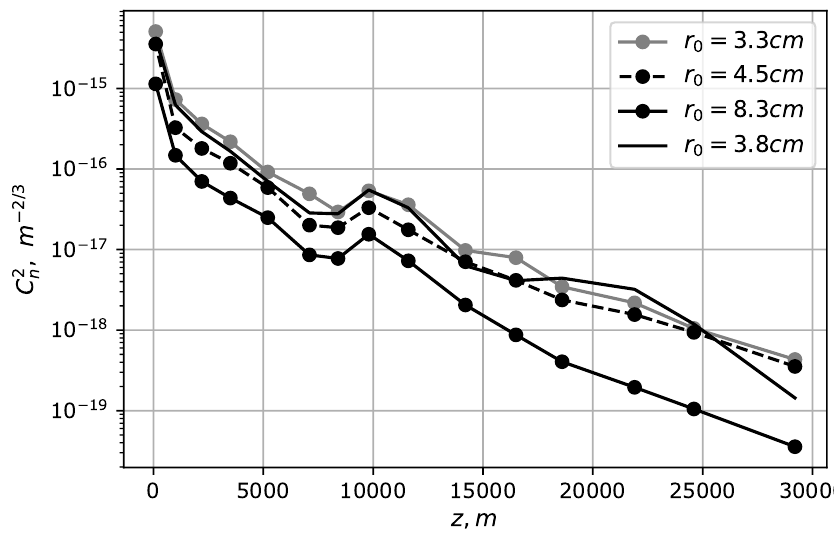
Figure 2. The vertical profiles of the structure constant of the air refraction index fluctuations at the Sayan solar observatory site. The vertical profiles correspond to different intensities of the atmospheric turbulence along light of